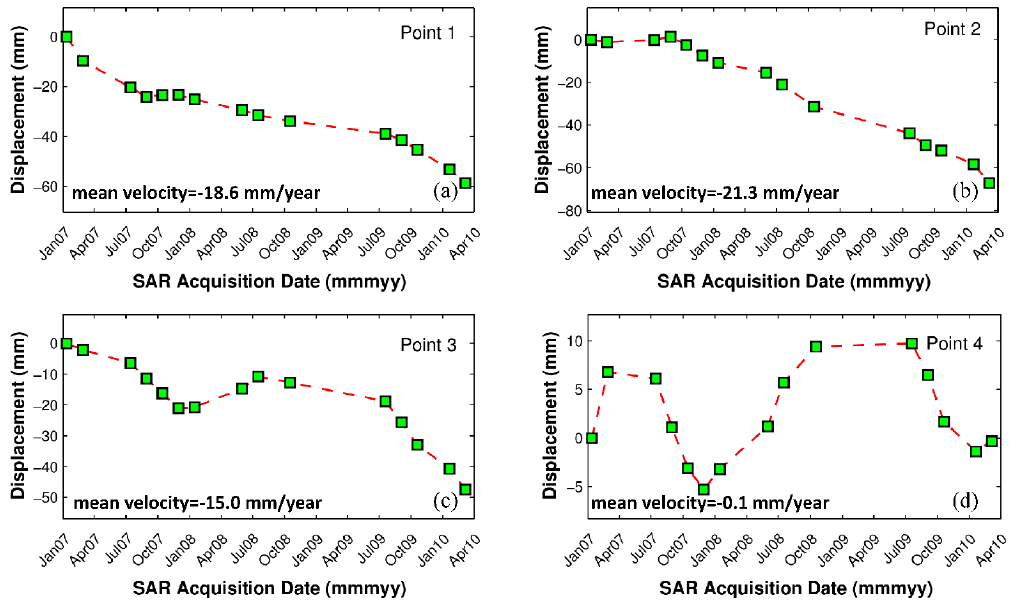
Figure 9. Time-series displacements for four points along the artificial side slope. ( a ) Point 1. ( b ) Point